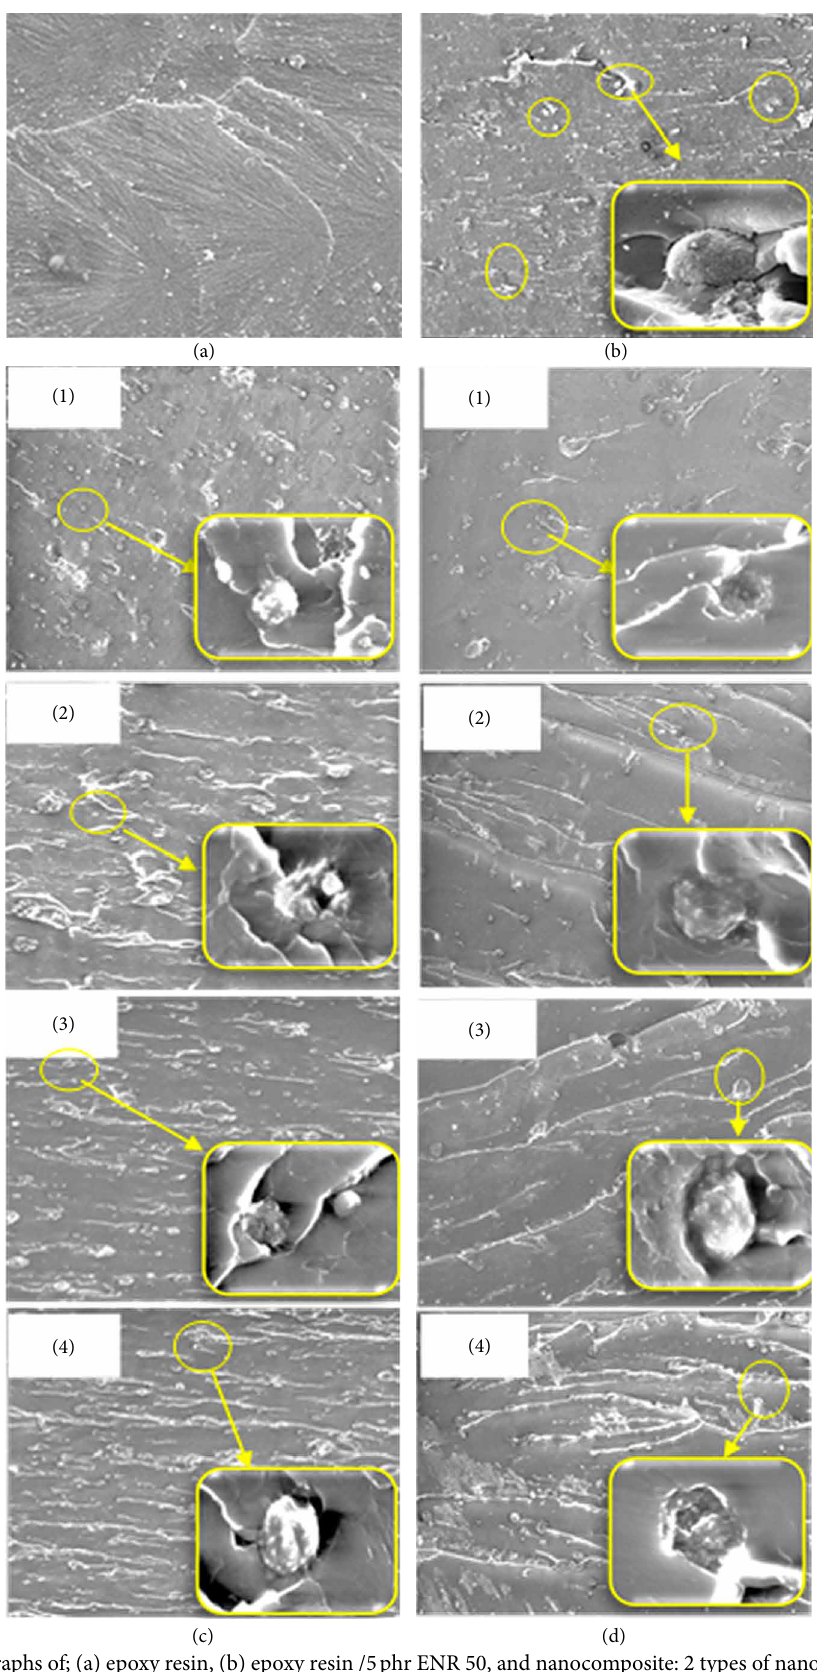
Figure 4: SEM micrographs of; (a) epoxy resin, (b) epoxy resin /5 phr ENR 50, and nanocomposite: 2 types of nanofillers: (c) nanocellulose, and (d) nanosilica, on nanofiller amounts: (1) 0.25 phr, (2) 0.5 phr, (3) 0.75 phr, and (4) 1.00